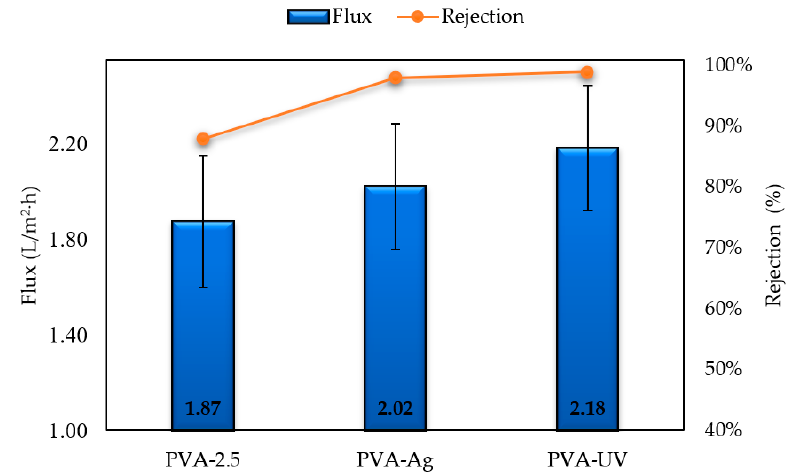
Figure 9. Flux measurements and bovine serum albumin (BSA) rejection of membranes crosslinked with 2.5% GA.